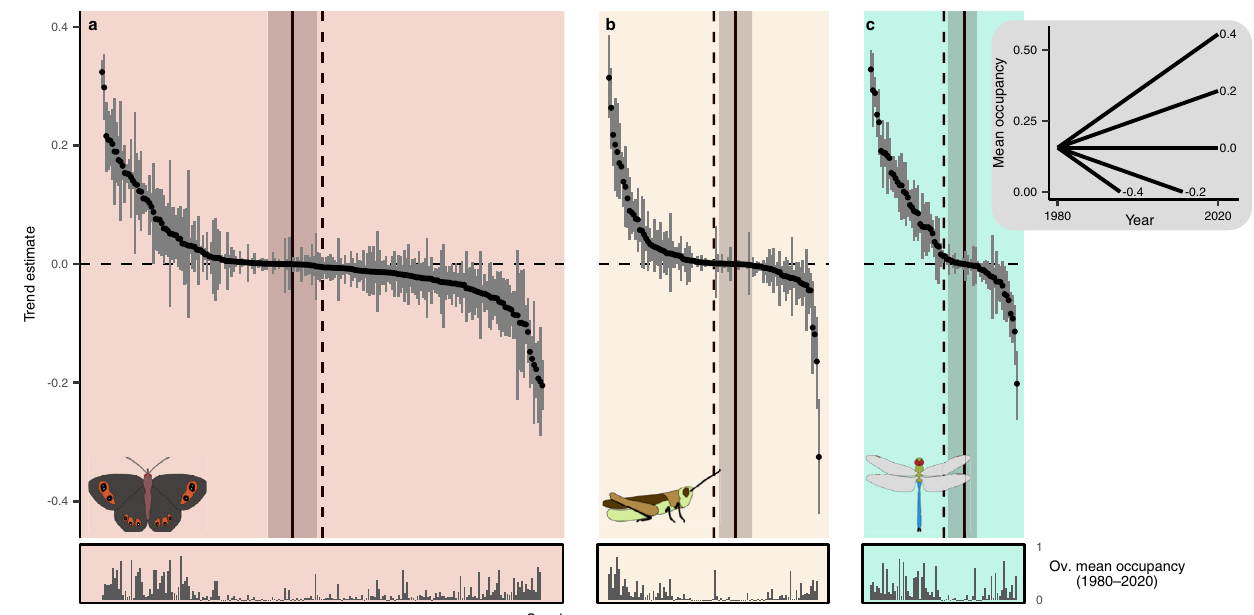
Fig. 2 | Trend estimates of mean occupancy across 40 years (1980 – 2020). 40- year trend estimates are shown for the ( a ) 215 butter fl y species, the ( b ) 103 grasshopper species and the ( c ) 72 dragon fl y species. Species are ordered along the point estimate of their trend (mean of posterior distribution), vertical seg- mentsshowthe95%credibleintervals.Trendestimatesre fl ecta40-yearchangein meanoccupancy,whichisillustrated intheinsetplotattherightstartingfromthe